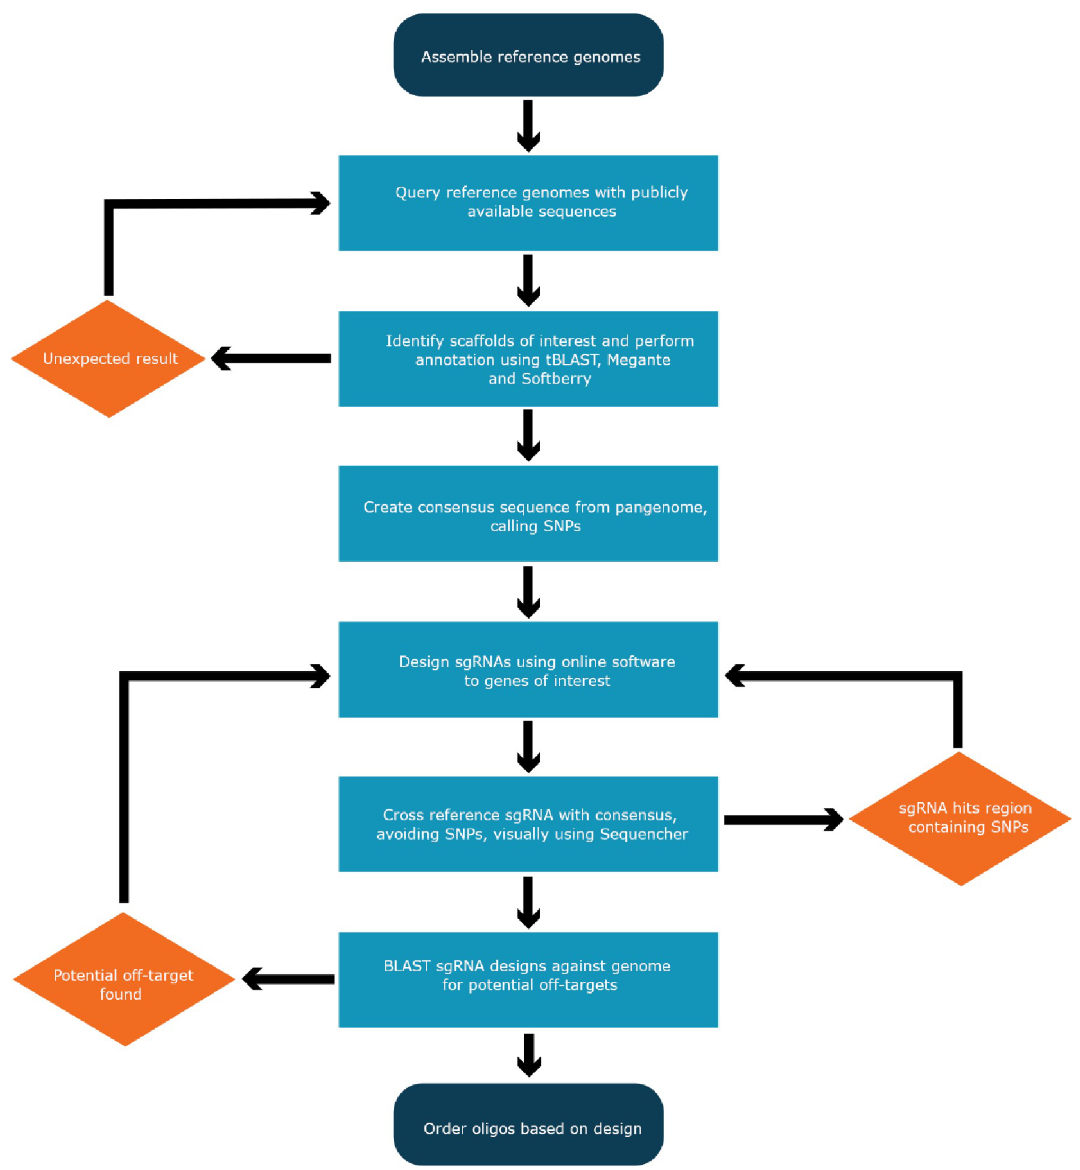
Fig 2. Informed genome editing pipeline for intelligent design of